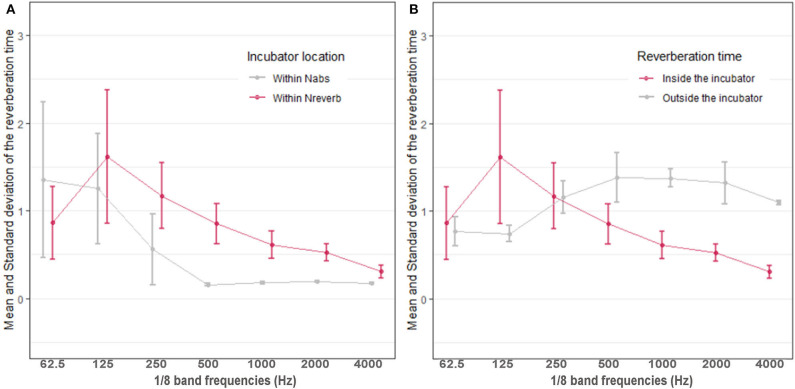
(A) Average reverberation time within the incubator in the reverberant (Nreverb, pink) and absorbent (Nabs, gray) rooms. (B) Reverberation time inside (pink) and outside (gray) the incubator in the reverberant room Nreverb.